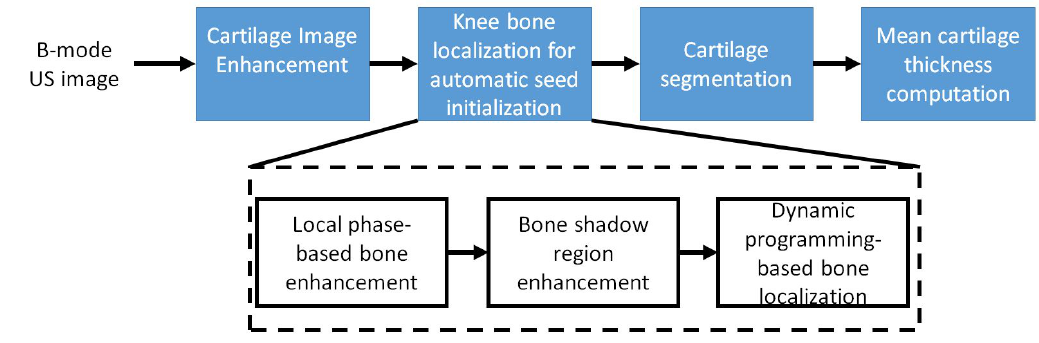
Figure 1. Flowchart of proposed cartilage-segmentation and thickness-measurement